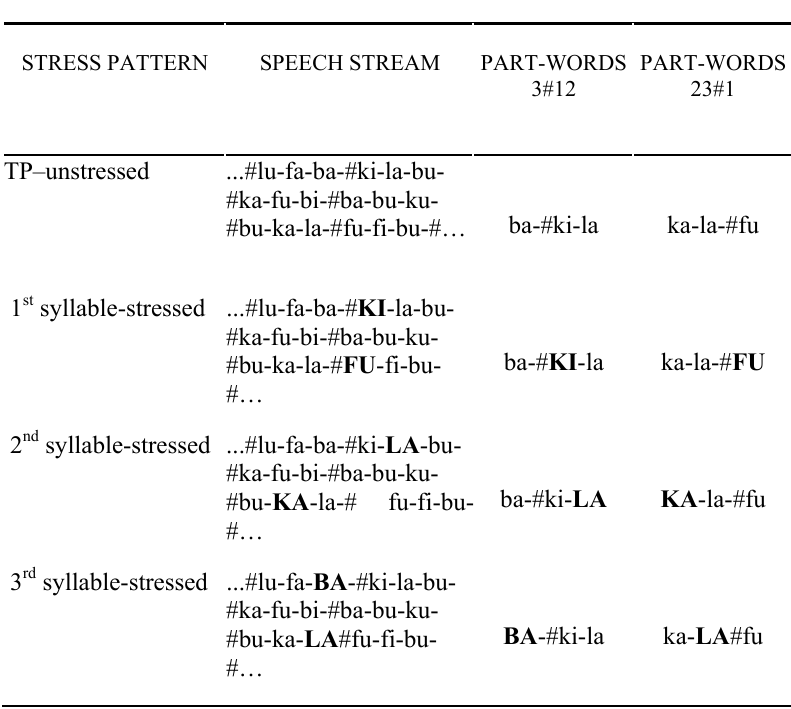
Table 2: Experiment 2B: Orthographic translation of a sample of the stream heard in the familiarization phase in the four conditions of stress location. The “#” defines word boundaries according to TPs; the “-” represents concatenation; TP-words with stressed syllables are in bold and the stressed syllable is presented in capitalized letters.